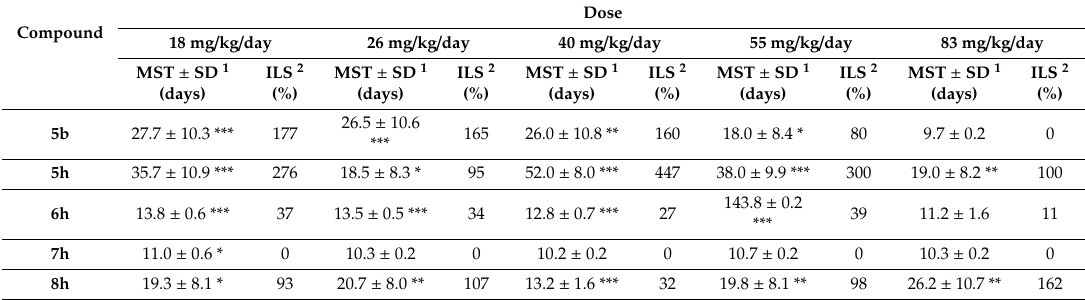
Table 3. Mean survival time and increased life span (ILS) of murine leukemia P388 at individual treatment with 5h , 8h , 5b , 6h , and 7h